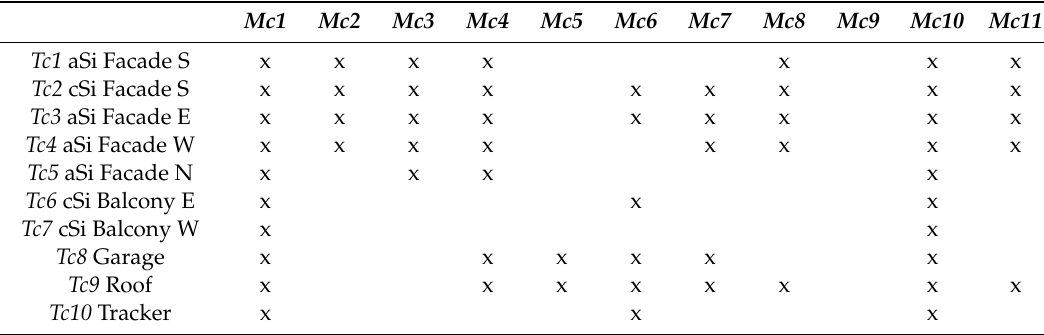
Table 2. MC definition. MC1 represents the current building status. MC9 is a passive reference